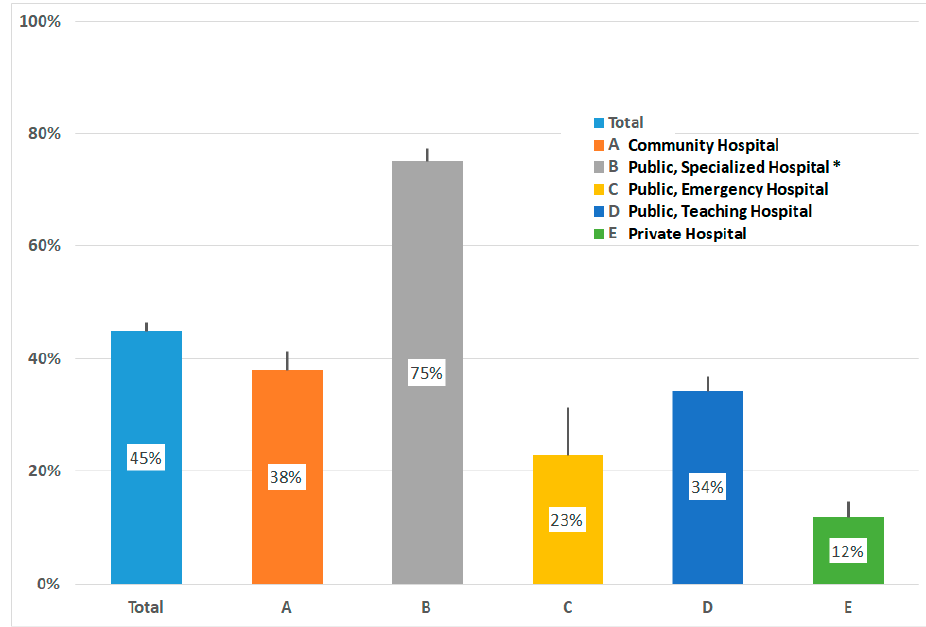
Figure 1. Percentage of exclusive breastfeeding; vertical lines indicate 95% CI. * Significantly different from A, C, D, E, p < 0.0001 chi-square test.